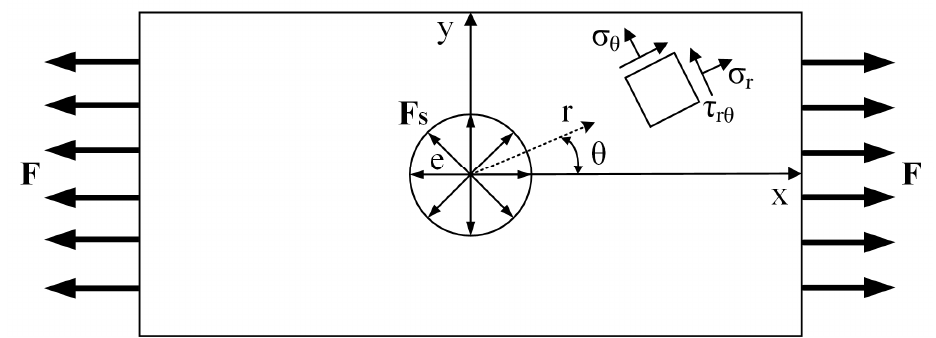
Figure 4. Schematic diagram of the polar coordinate on the plate surface. F : Tensile force; F s : squeezing force on the hole wall; e : Rivet hole radius; σ θ : Circumferential stress; σ r : Radial stress; τ r θ : Shear stress; 𝑟 : Radius of polar coordinate system; and 𝜃 : Angle of polar coordinate system.